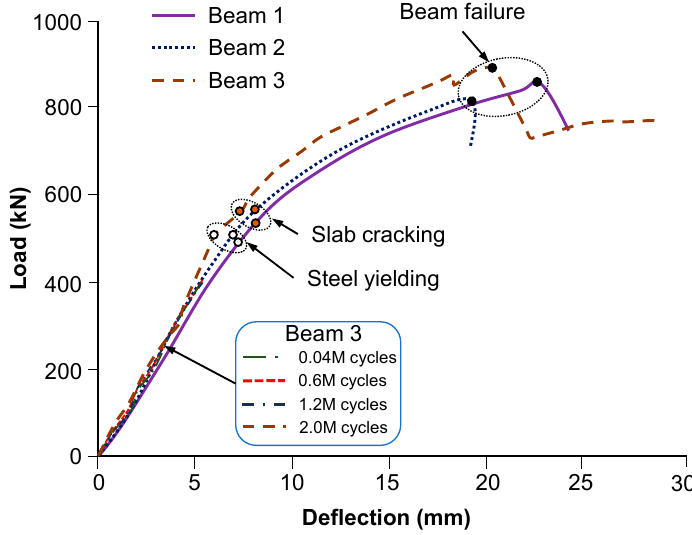
Figure 13. Longitudinal strain distributions over mid-span section of Beam 3.